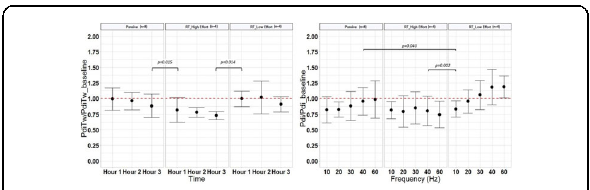
Fig. 2 (abstract 001058). See text for